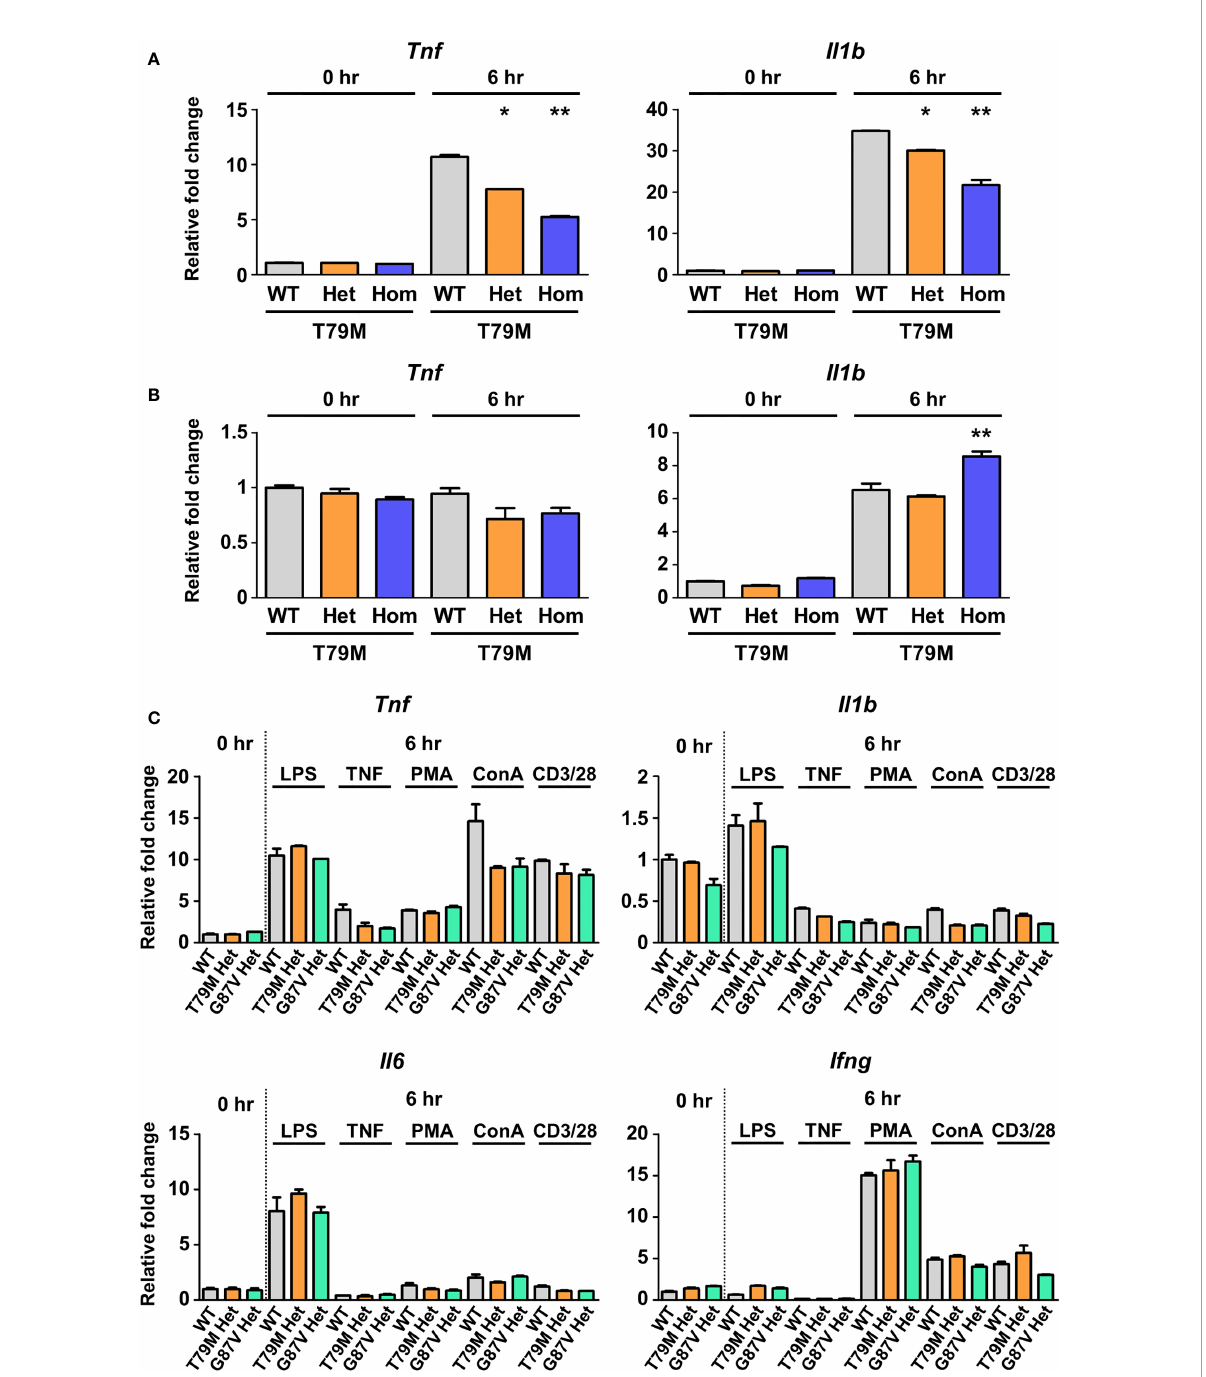
FIGURE 8 No substantial differences in the responses to in fl ammatory stimuli in TRAPS mutant macrophages and splenocytes. T79M TRAPS mutant bone marrow-derived macrophages were stimulated with 100 ng/mL LT a (A) or 10 mM norepinephrine (B) . RNA samples were collected before and 6 h after the stimulation. The mRNA expression levels of Tnf and Il1b were determined using qPCR. The cell culture experiments were performed separately for each strain. (C) Murine splenocytes were collected from indicated mice. The splenocytes were treated with LPS, TNF a , PMA plus ionomycin, ConA, and anti-CD3 ϵ /CD28 antibodies. mRNA expression levels of proin fl ammatory cytokines were determined using qPCR. The WT levels at 0 h were set to 1. * p <0.01 vs . T79M WT. ** p <0.01 vs . T79M WT and Het 6 h after stimulation of LT a or norepinephrine. TRAPS, TNF receptor-associated periodic syndrome; LT a , lymphotoxin a ; LPS, lipopolysaccharide; PMA, phorbol 12-myristate 13-acetate; ConA, concanavalin A; qPCR, real-time quantitative polymerase chain reaction; WT, wild-type; Het, heterozygote; Hom,